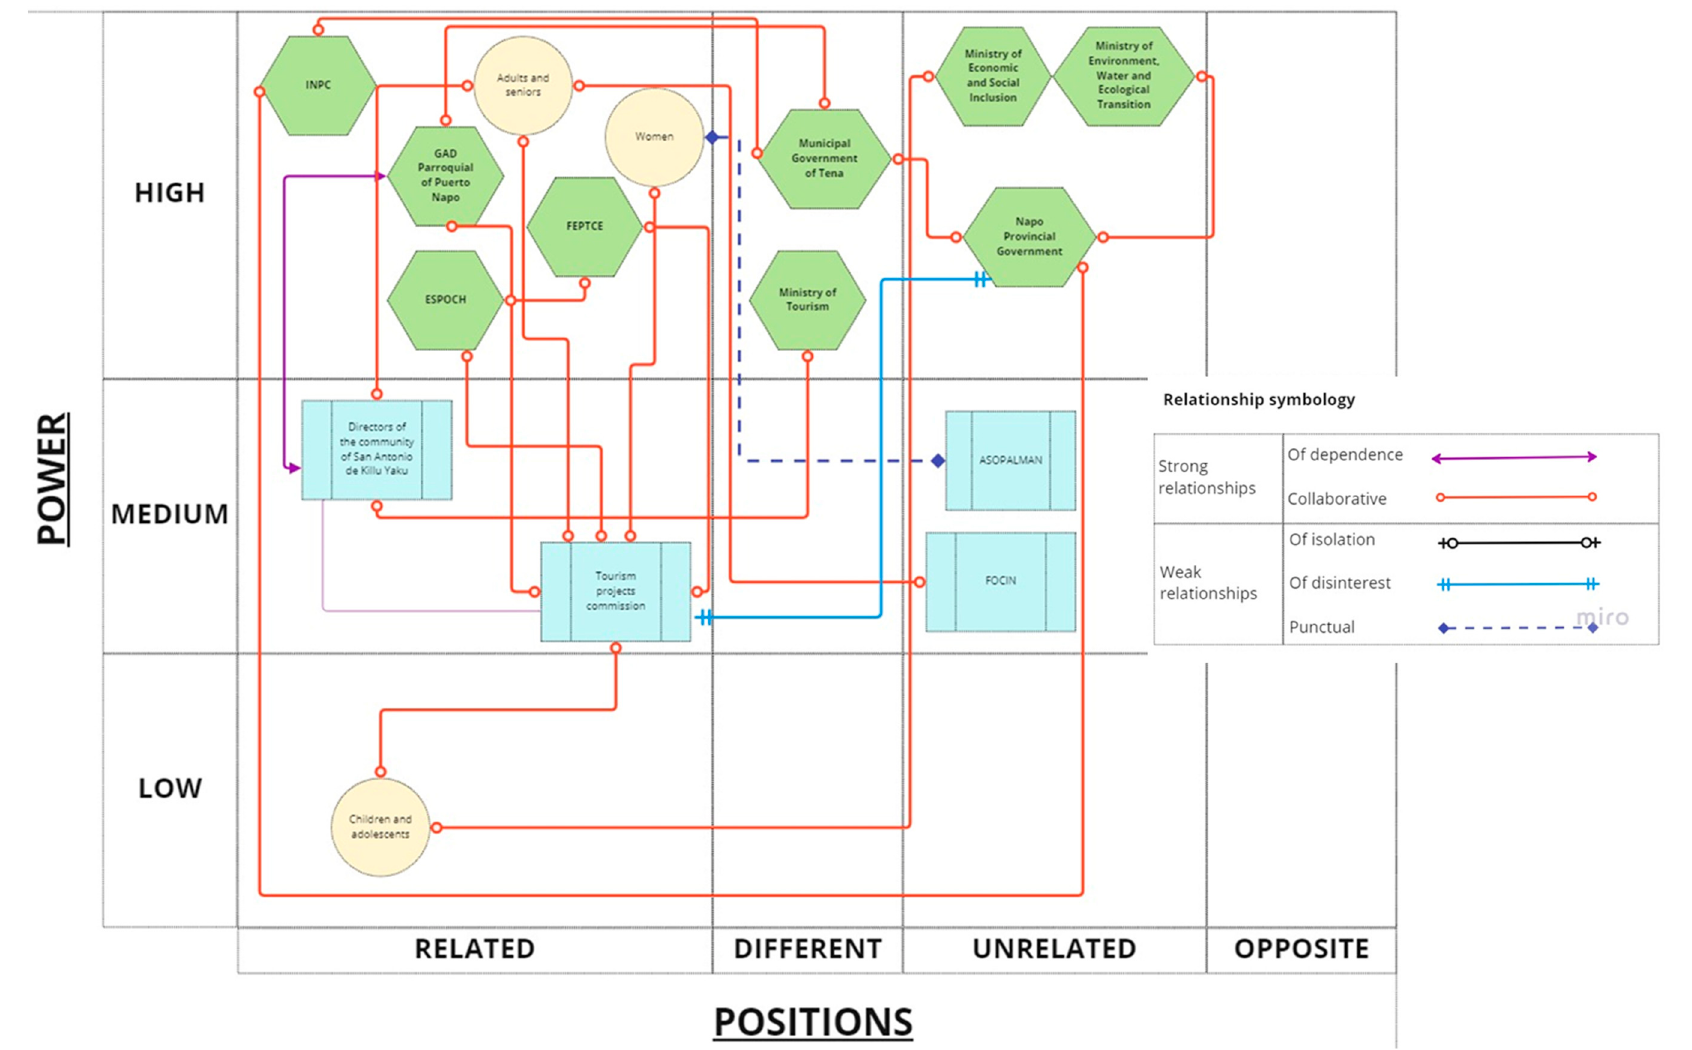
Figure 2. Mapping of the social actors in the territory.